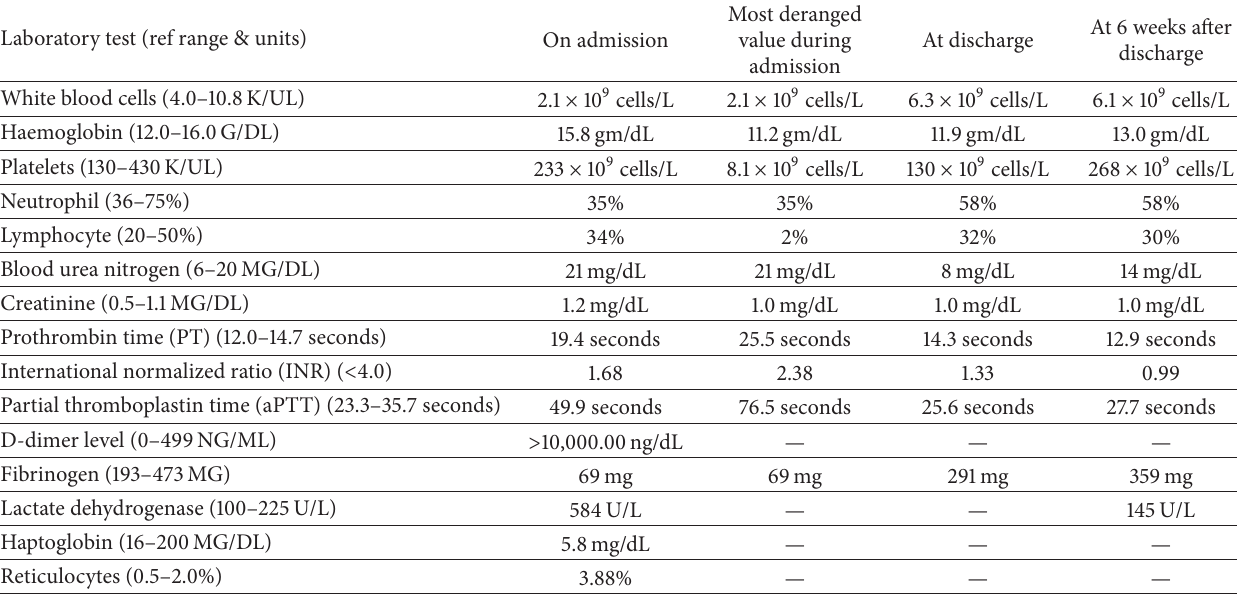
Table 1: Lab results on admission and most deranged value at discharge and six weeks after discharge. Laboratory test (ref range & units) White blood cells